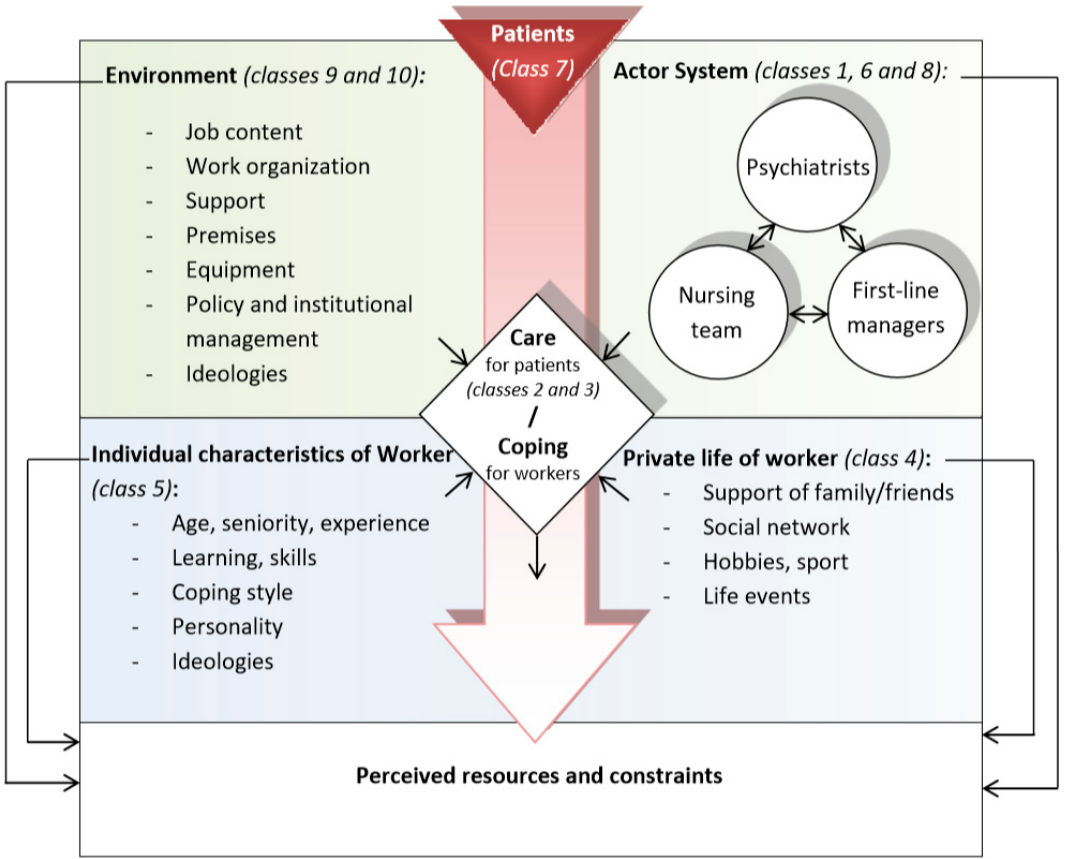
Figure 1. Hypothetical model of the relationship between classes in the generation of perceived resources and